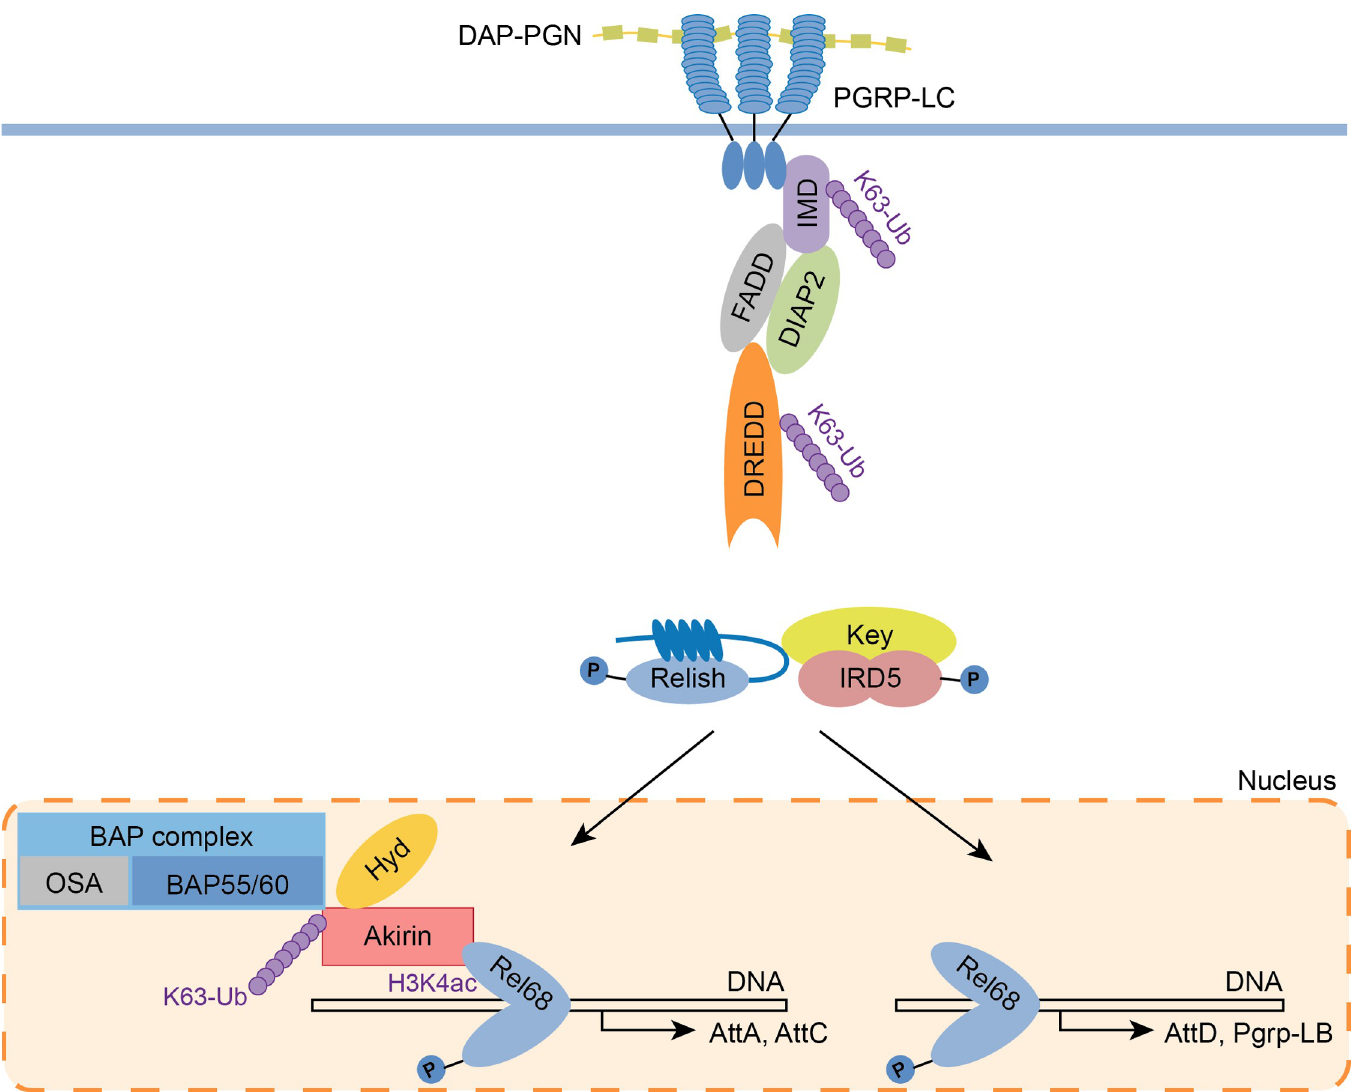
Fig 5. Schematic model of Hyd involvement in the IMD signaling pathway in Drosophila . Model showing the role of Hyd in the expression of the Akirin-dependent genes in the IMD pathway. After activation of the pathway, allowed by the K63-polyUb chains deposition on the complexes IMD and DREDD by the E3-ubiquitin ligase Diap2, Relish is translocated. Hyd is necessary for the K63-polyUb of the NF- κ B co-factor Akirin and its interaction with the NF- κ B factor Relish. This interaction is crucial for the expression of Akirin-dependent genes (like Attacin-A and Attacin-C ), necessary for an adequate innate immune response. DAP-PGN: meso- diaminopimelic acid-type peptidoglycan of Gram-negative bacteria, P-tag: phosphorylation marks.